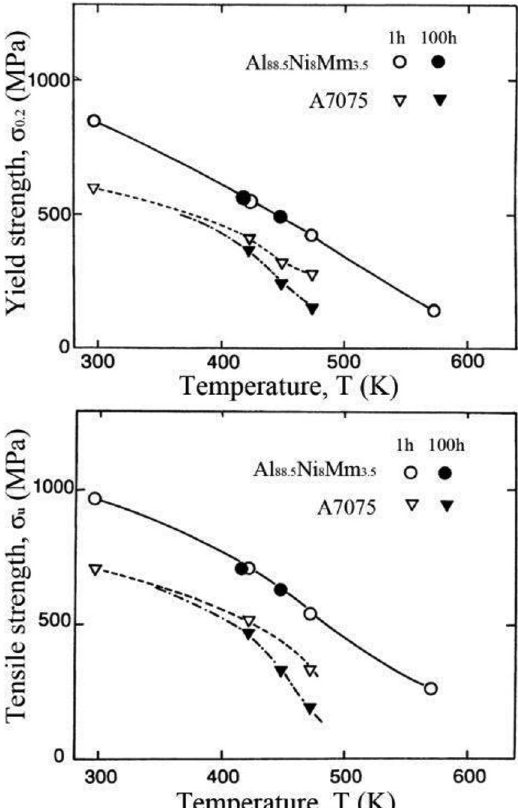
Figure 8. Temperature dependence of tensile yield strength (σ and ultimate tensile strength (σ annealed for 1 and 100 h at each testing temperature. The data for the A7075 alloy are also shown for comparison 29